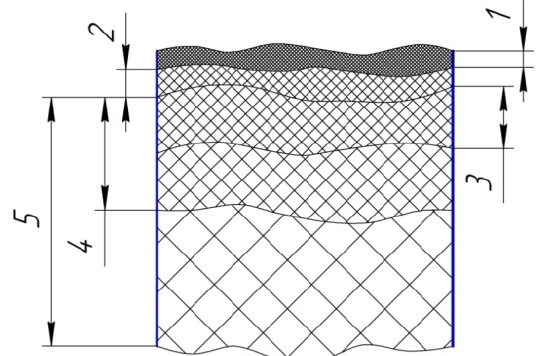
Figure 2. Schematic location of the zones of the surface layer after the EDM: 1—zone of saturation with elements of the working fluid; 2—zone of deposition of the material of the electrode-tool; 3—white layer formed from molten workpiece material; 4—heat affected zone; 5—zone of plastic de- formation.